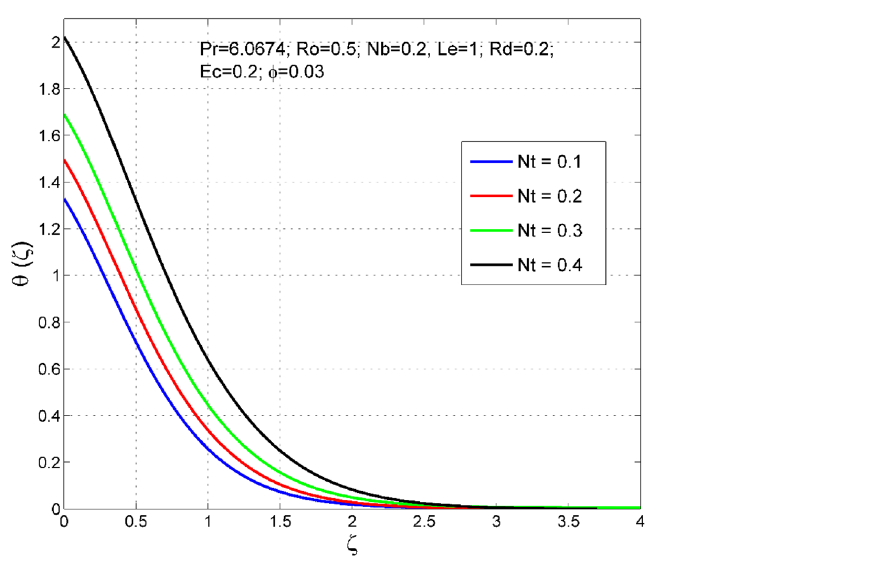
Figure 8. Effect of Nt on θ (ζ)